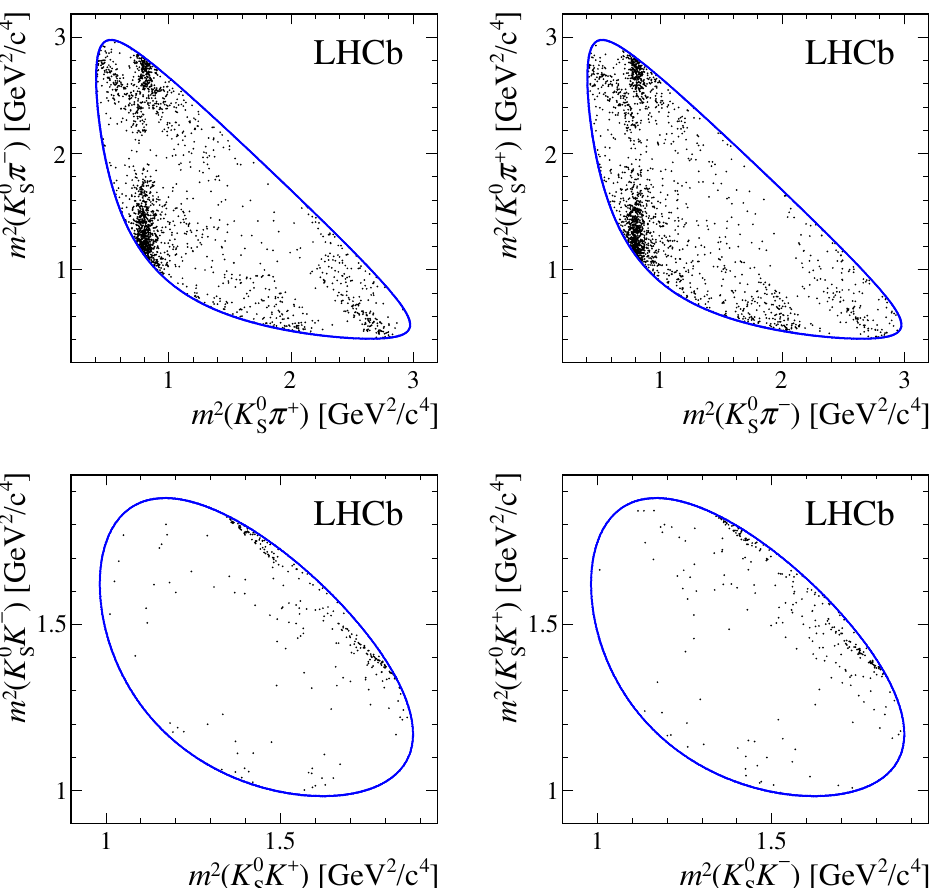
Figure 2 . Dalitz plots of long and downstream (left) B + ! DK + and (right) B (cid:0) ! DK (cid:0) candidates for (top) D ! K 0 (cid:25) + (cid:25) (cid:0) and (bottom) D ! K 0 K + K (cid:0) decays in which the reconstructed S S invariant mass of the B (cid:6) candidate is in a region of (cid:6) 25 MeV =c 2 around the B (cid:6) mass. The narrow region is chosen to obtain high purity, as no background subtraction has been made. The Dalitz coordinates are calculated using the results of a kinematic (cid:12)t in which the D and K 0 masses are S constrained to their known values. The blue lines show the kinematic boundaries of the